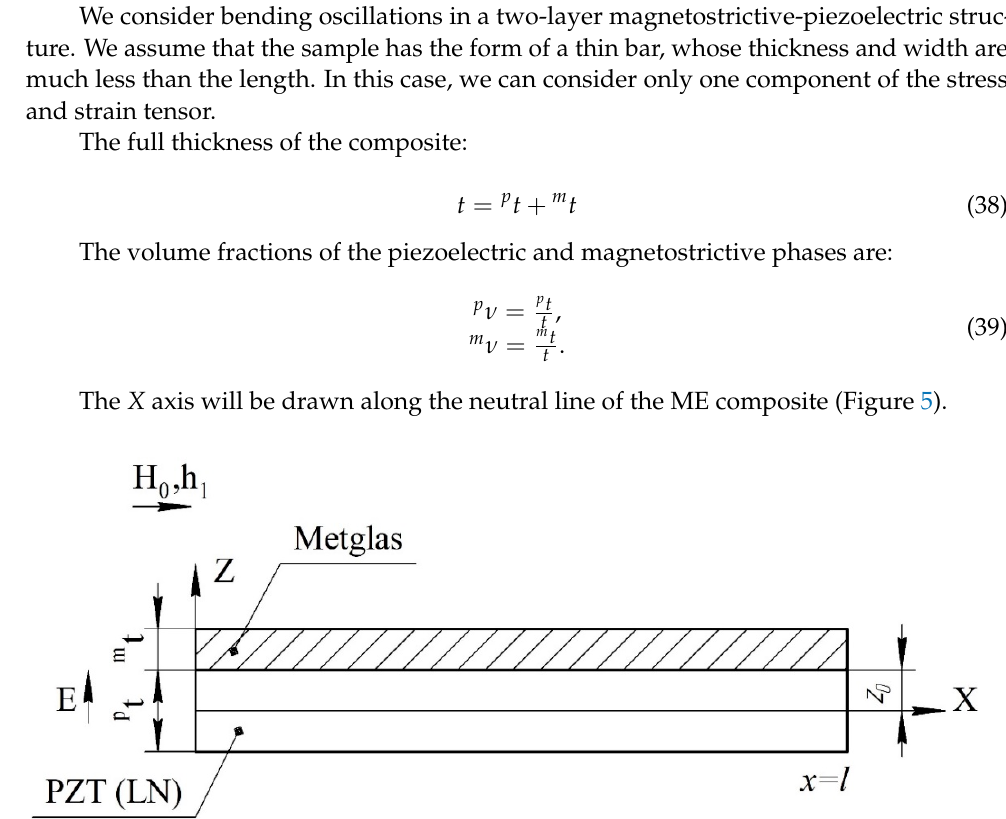
Figure 5. The position of the boundary between the piezoelectric and magnetostrictive phases relative to the neutral line in a two-layer composite.